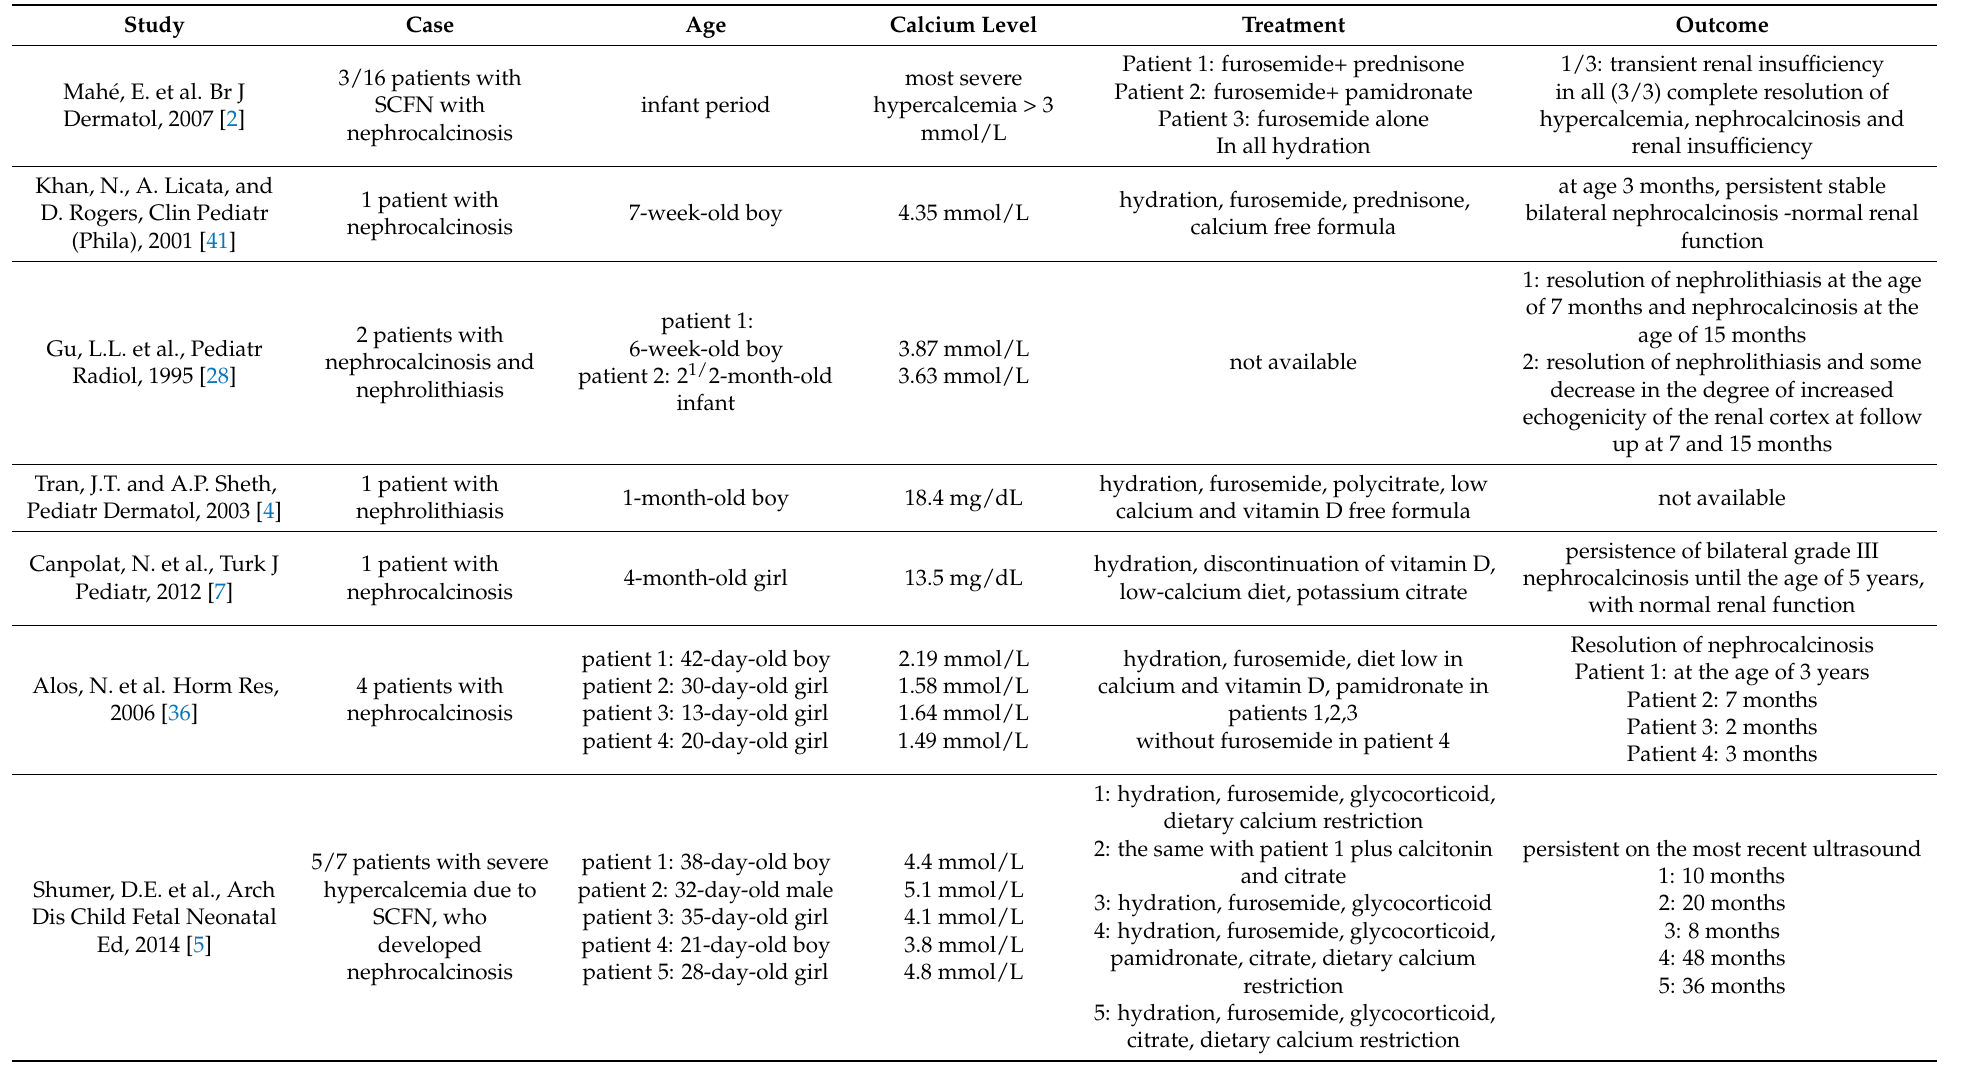
Table 1. Summary of SCFN cases complicated with nephrocalcinosis and